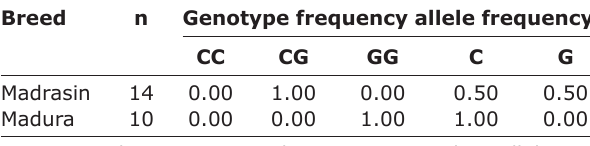
Table-2: Genotype frequency and rFSH gene allele in Madrasin cattle. Keterangan. Breed n Genotype frequency allele